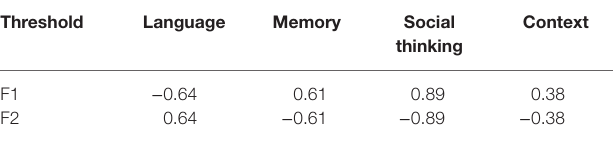
TABLE 1 | Thresholds between successive response categories (F1-F2). Threshold Language